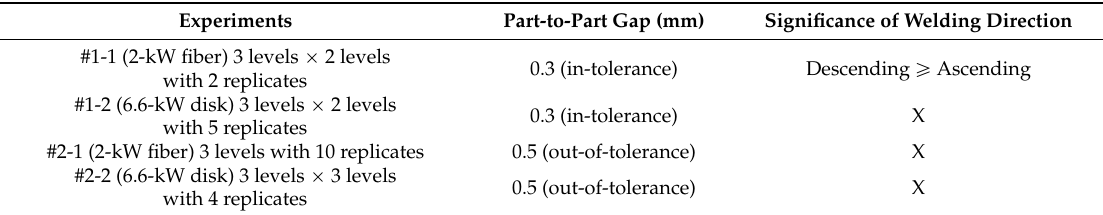
Table 17. Summary of the four